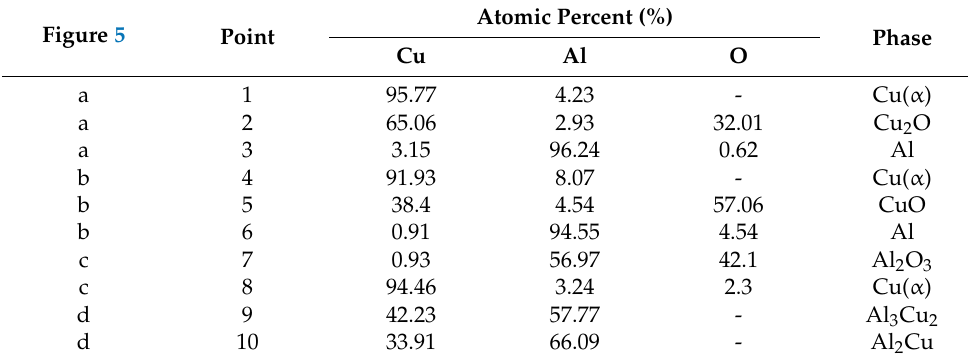
Figure 5. Backscattered SEM micrograph of cold-pressed samples comprising differently milled powders ( a ) C1, ( b ) C2, ( c ) C3, and ( d ) higher magnification of C3 smaller intersect. Table 2. EDS analysis corresponding to related points of Figure